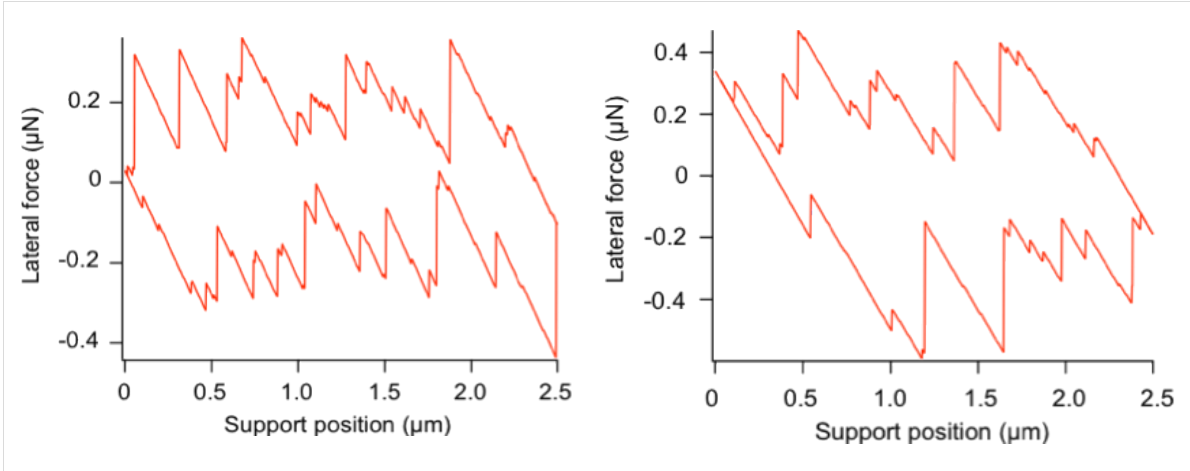
Figure 7: Examples of curves simulated with the stochastic Prandtl–Tomlinson model for two realizations of the same stochastic process, mimicking the experimental conditions of the measurement of Figure 2.